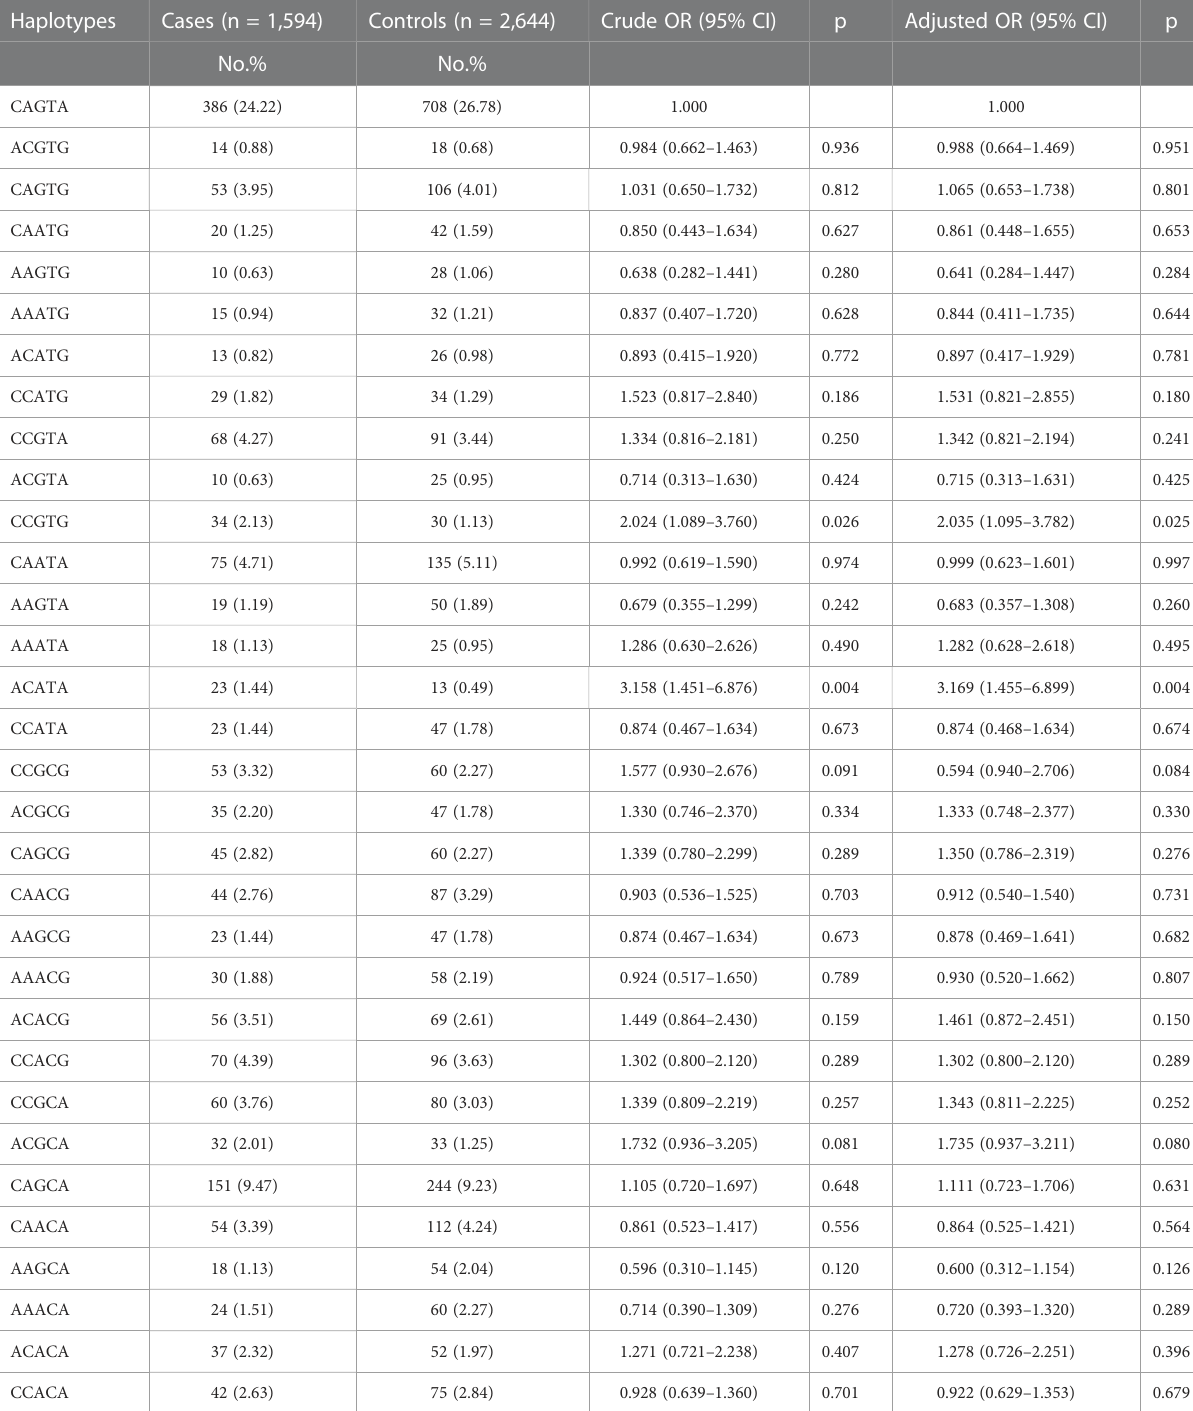
TABLE 3 Association between inferred haplotypes of the m5C-related genes and pediatric ALL risk.